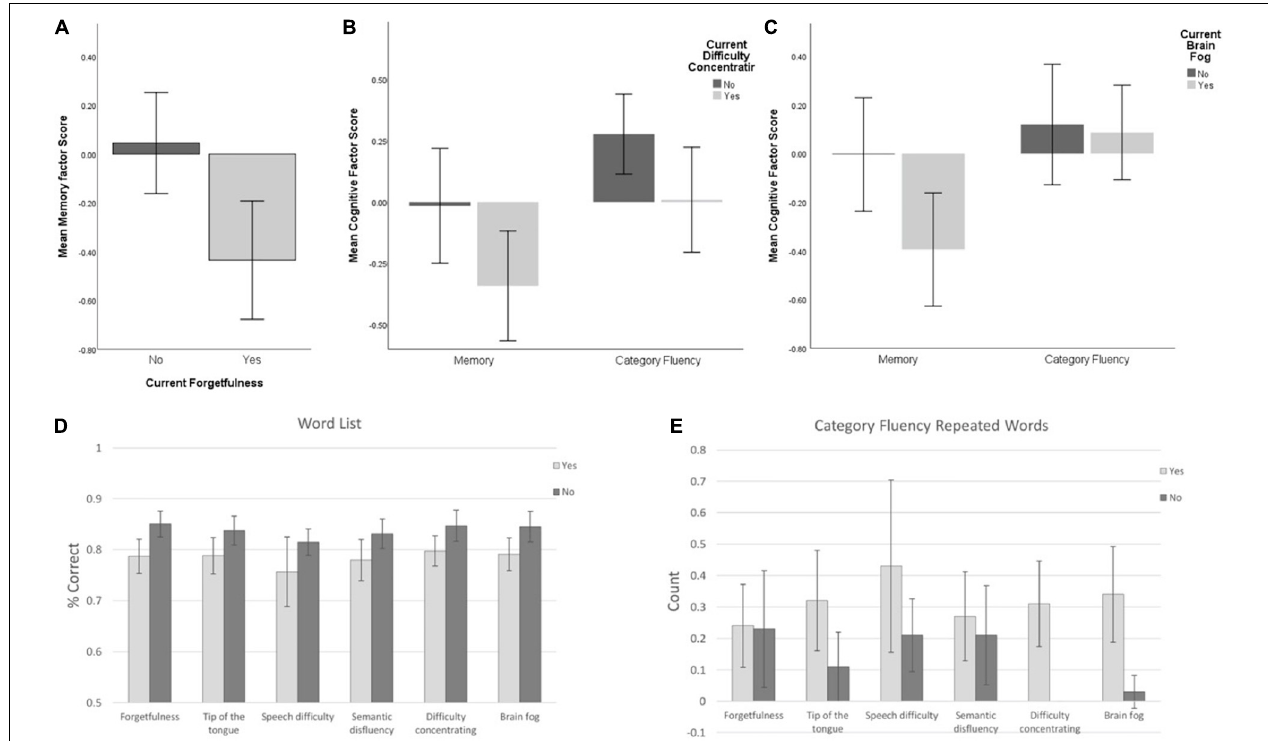
FIGURE 5 | (A) Memory factor score for those reporting (or not) current forgetfulness. (B) Memory and Category Fluency factor scores for those reporting (or not) current difficulty concentrating or (C) brain fog. (D) Word List % correct among groups with/without current cognitive symptoms; (E) Category Fluency repetitions among groups with/without current cognitive symptoms. Error bars: ± 2